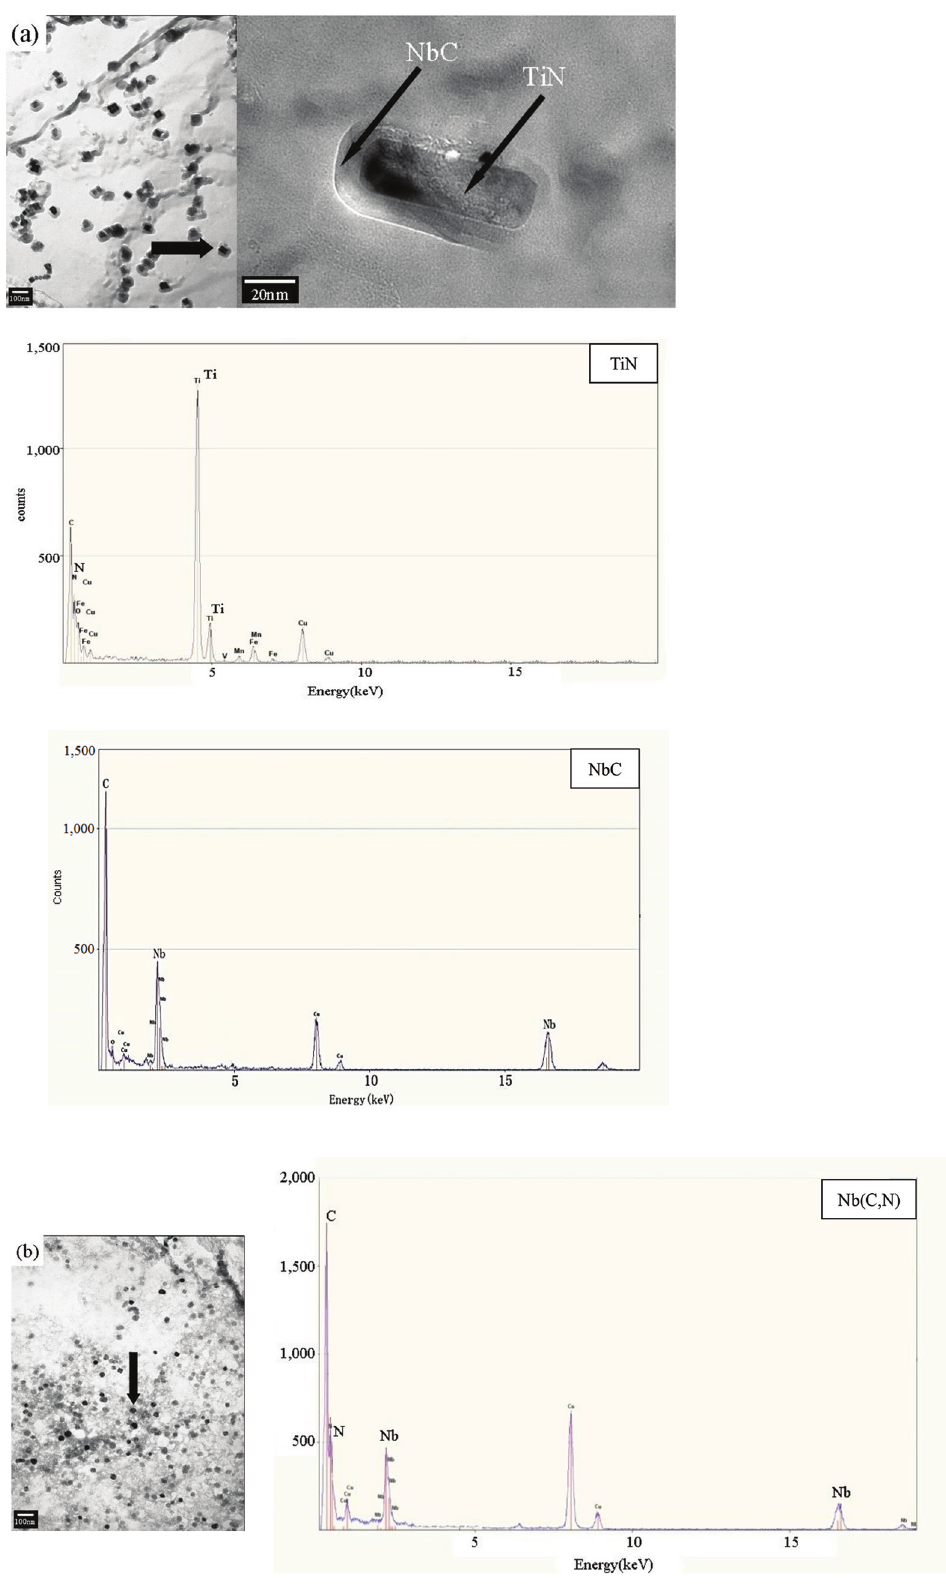
Figure 9: TEM micrograph and EDS spectrum of precipitates in (a) steel A and (b) steel B at